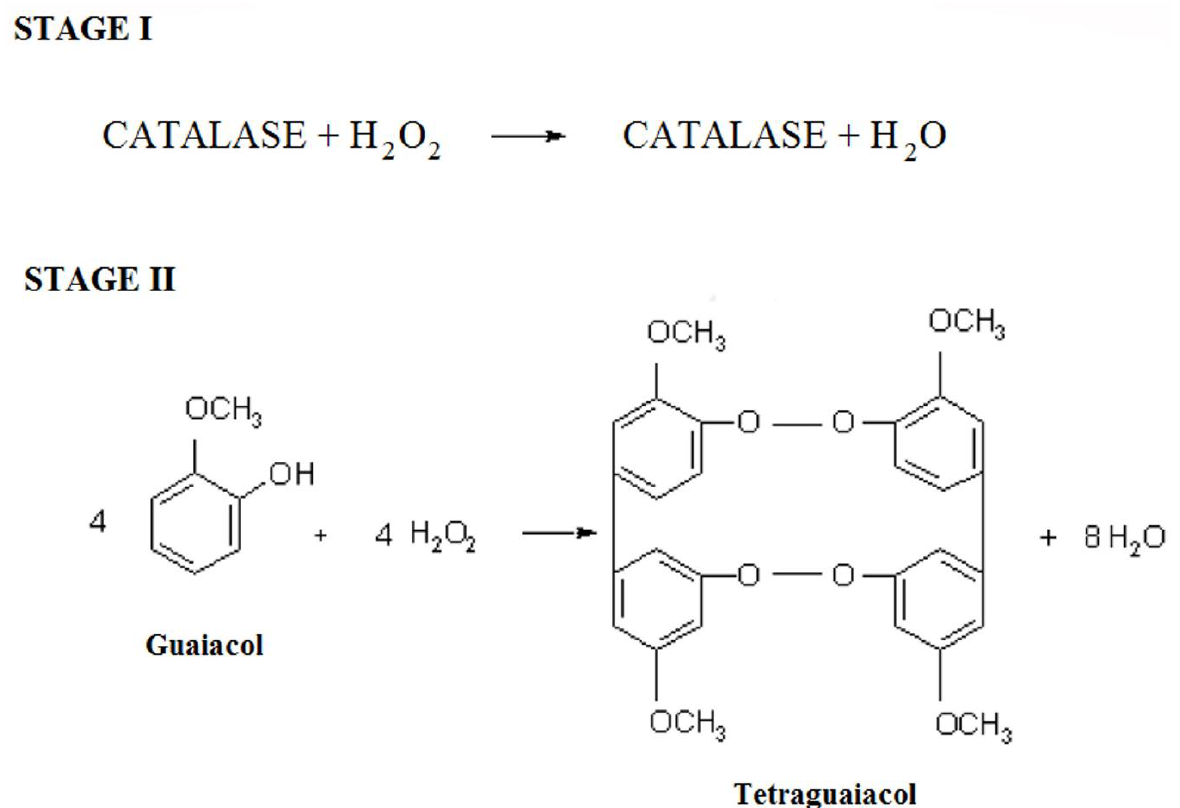
Figure 8. Reaction scheme for the determination of catalase activity.